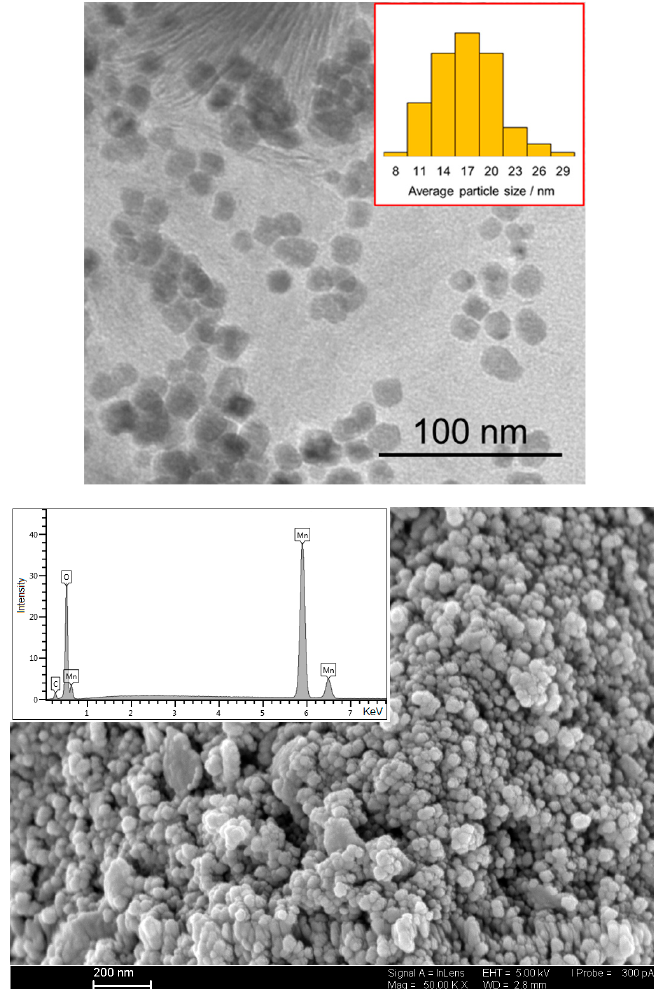
Figure 1. SEM, EDX, and TEM analysis of the obtained MnO nanoparticles. The particle size distri- bution is shown in the inset.